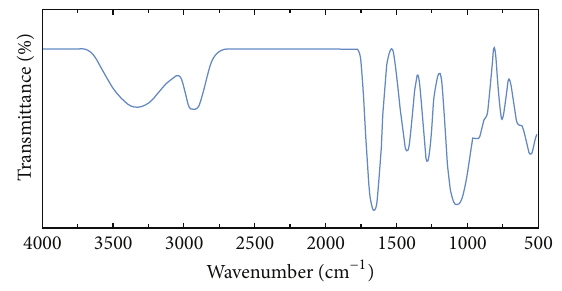
Figure 1: FTIR of TMEVS/NVP copolymer.